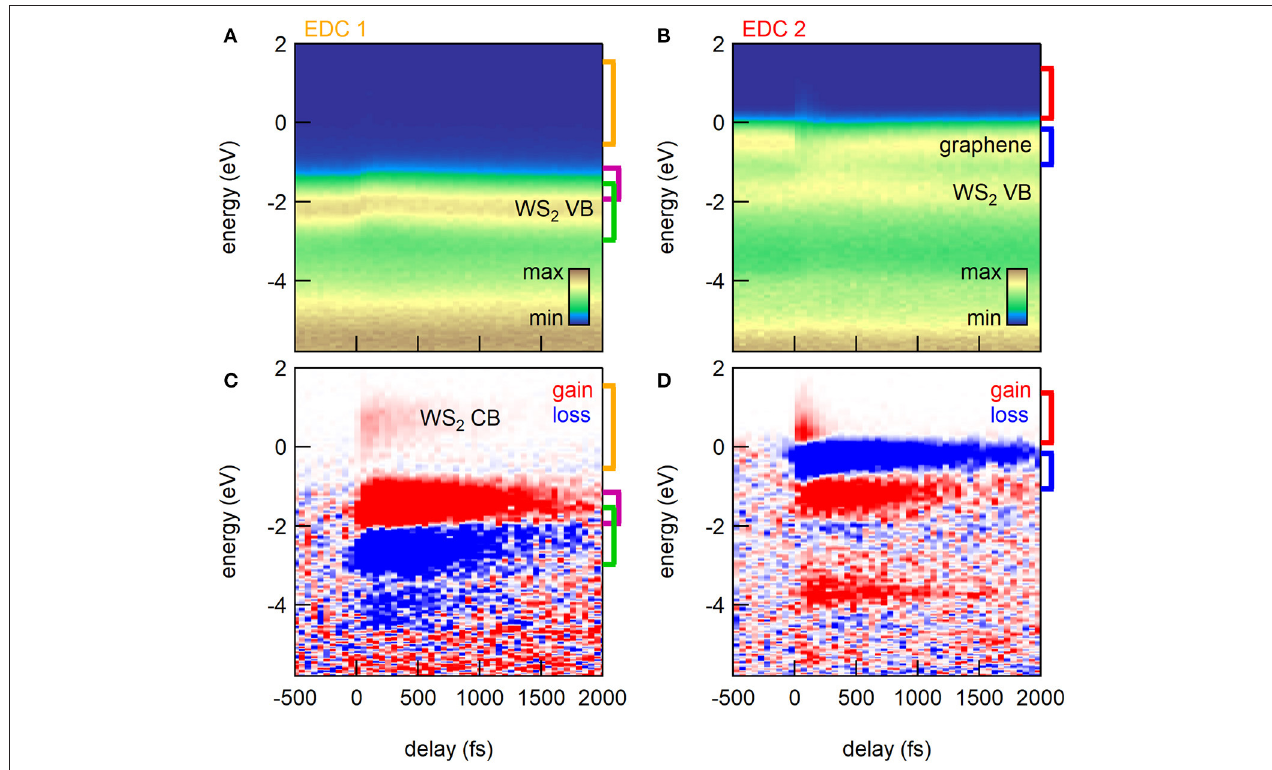
FIGURE 3 | Time- and angle-resolved photoemission spectroscopy (tr-ARPES). (A,B) Time-resolved EDCs measured along the orange (EDC1) and red lines (EDC2), respectively, in Figure 2D as a function of pump-probe delay after photoexcitation at ¯ h ω pump = 2eV. (C,D) Pump-induced changes of EDC1 and EDC2, respectively, obtained by subtracting the equilibrium EDC taken at negative pump-probe delay from all transient EDCs. Red and blue correspond to gain and loss of photoelectrons with respect to negative pump-probe delay, respectively. Colored brackets indicate the integration ranges for the data presented in Figure 4